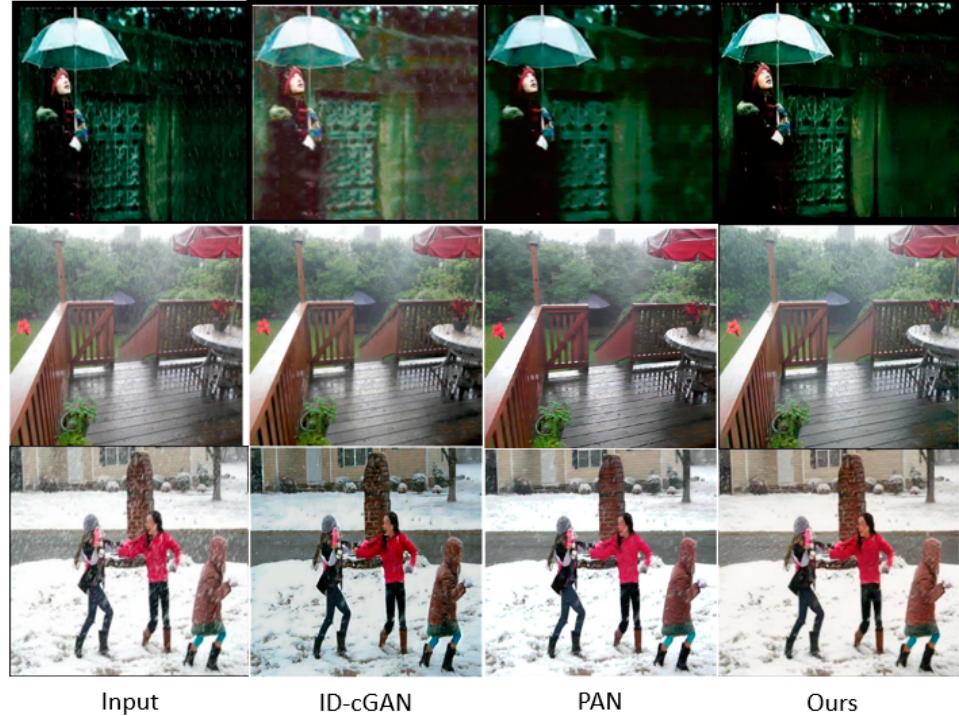
Figure 3. Comparison of de-raining tasks with ID-cGAN and PAN on a real rainy image.